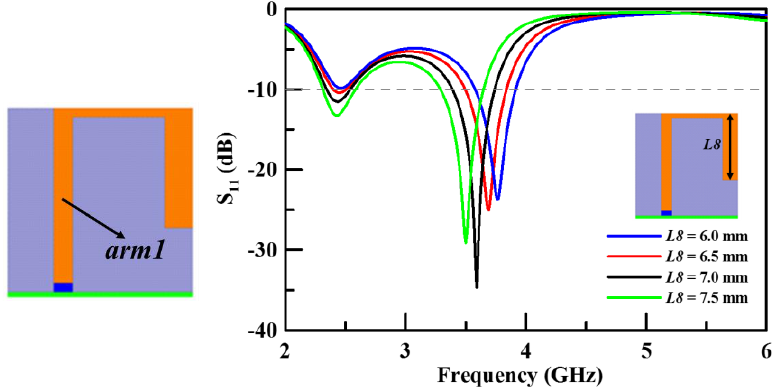
Figure 4. The simulated return loss with various lengths of L8 (Step 1).